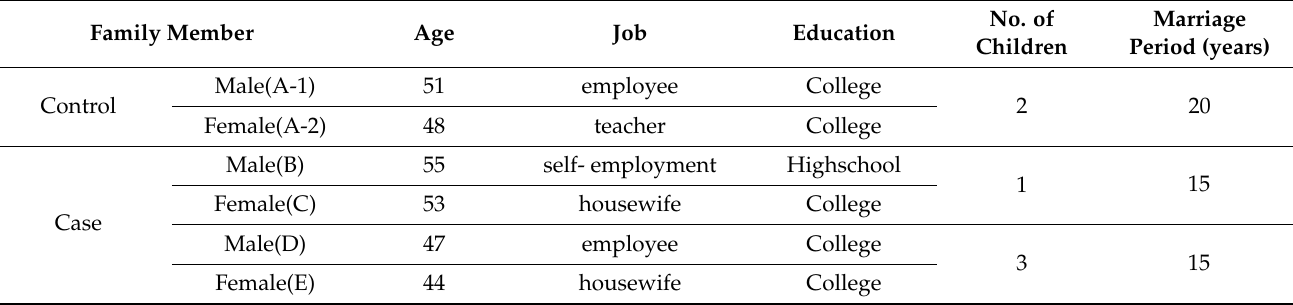
Table 1. General characteristics of the study participants.